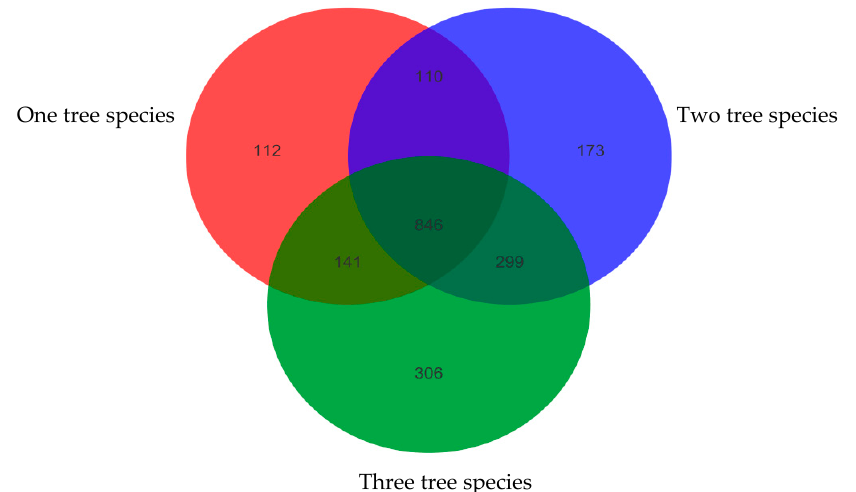
Figure 2. Venn diagram of the number of shared and unique OTUs in tree clusters of varying tree species richness (with one, two, and three tree species combinations), after normalizing the number of reads. The sequence similarity of fungal OTU was 97%. Species 1, Species 2 and Species 3 represent a tree species richness of one, two, and three, respectively (for more descriptions see Figure 1).